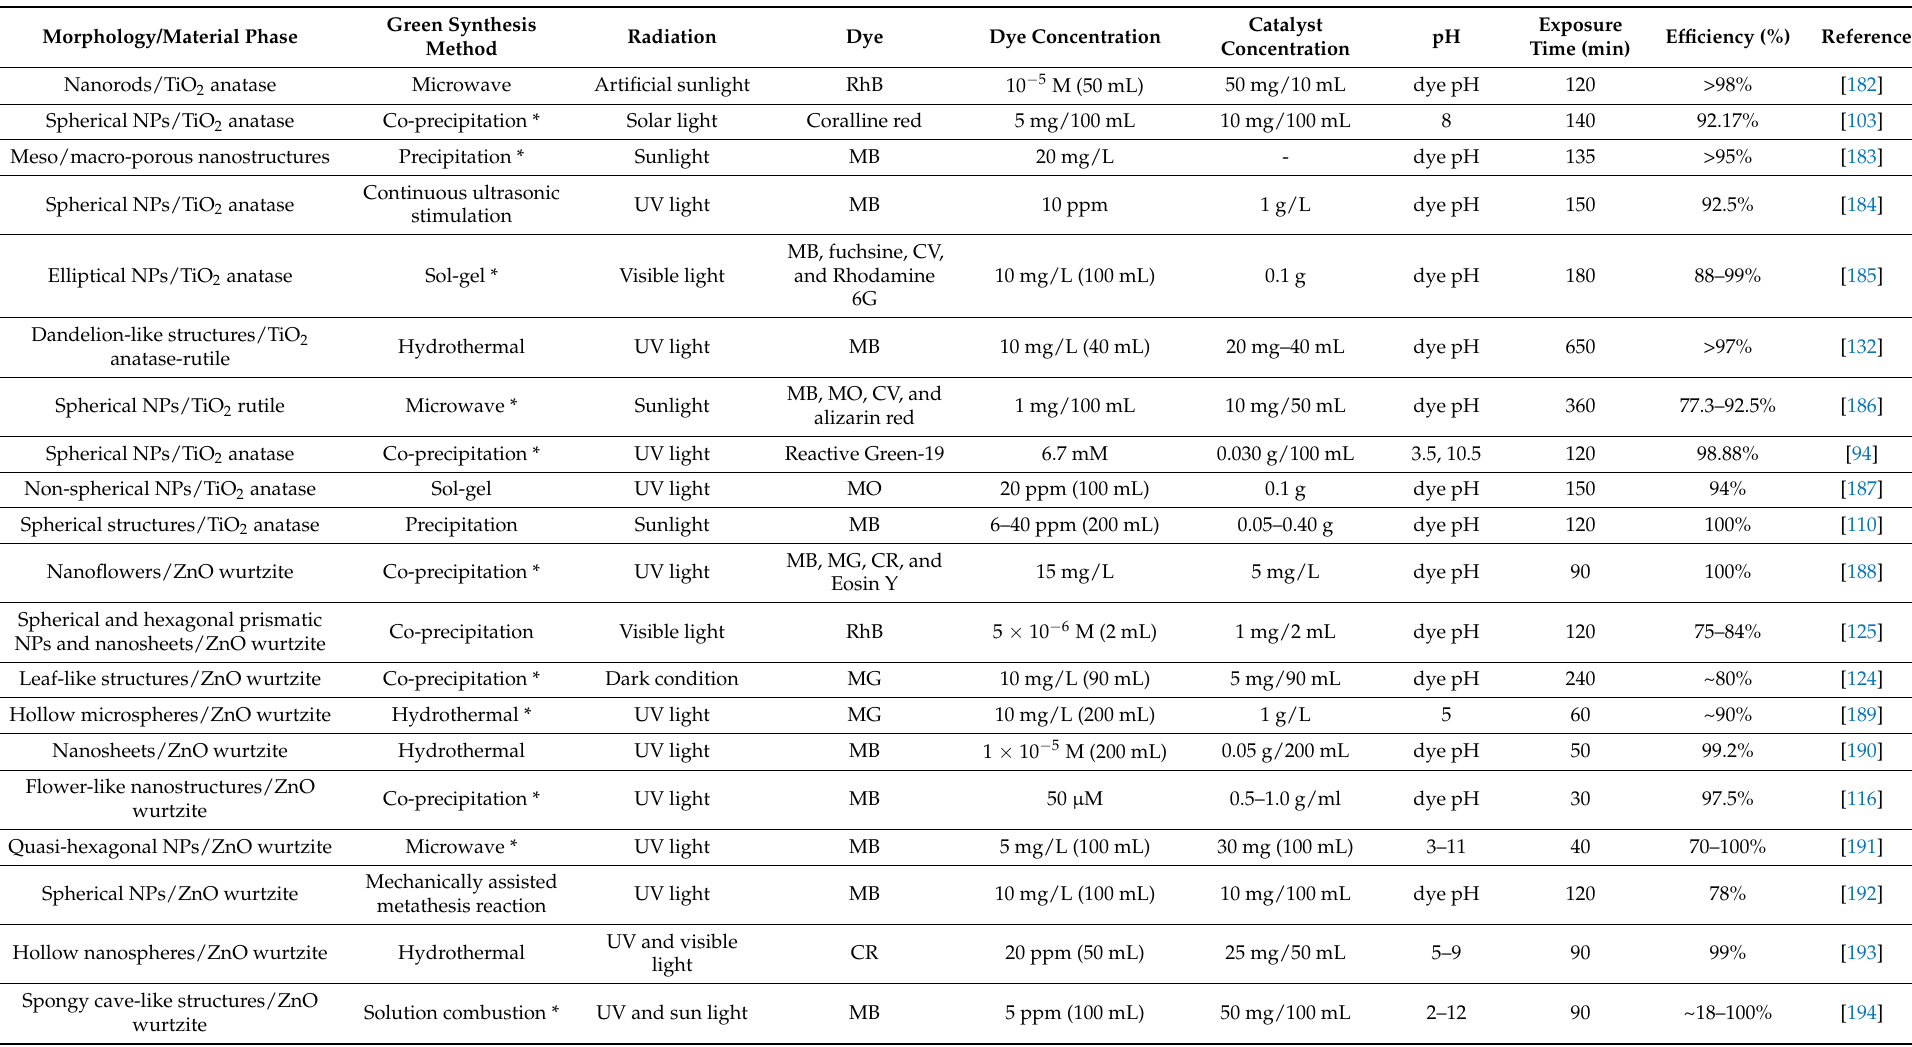
Table 5. Parameters involved in the process of dye photodegradation by TiO 2 and ZnO nanostructures synthesized by green routes. The dyes methylene blue, rhodamine B, malachite green, methyl orange, Congo red and crystal violet are indicated by the abbreviations MB, RhB, MG, MO, CR and CV,